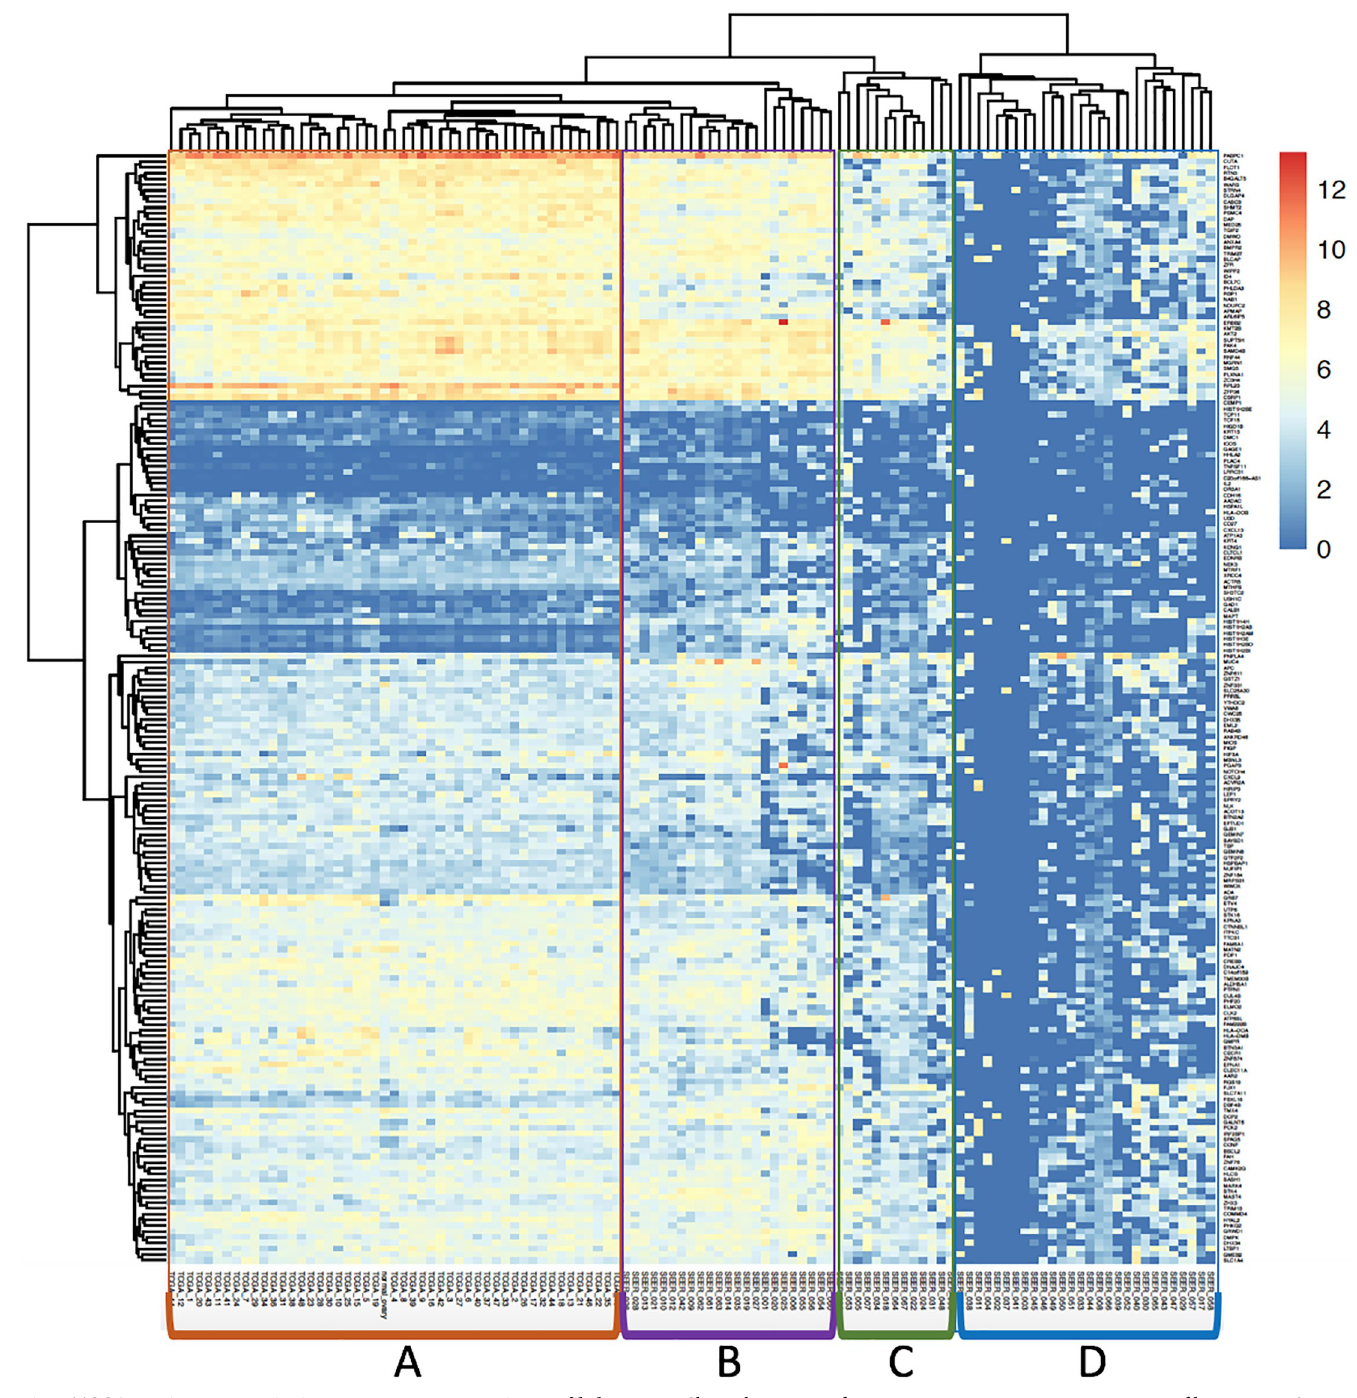
Fig 8. TCGA ovarian prognostic signature gene set expression profile heat map. Cluster heat maps of 193 ovarian prognostic signature gene profile among 67 SEER FFPE samples, 48 TCGA ovarian tumor samples and one Human BodyMap normal ovary tissue sample. Each row represents a gene and each column represents a sample. The color and intensity of the boxes represent changes of gene expression. Genes and samples have been hierarchically clustered based on their gene expression pattern. Group A samples contain the 48 TCGA ovarian tumor samples and one Human BodyMap ovary tissue sample. Group B samples are the 26 SEER samples which display a good correlation with TCGA ovarian tumor samples. Group C samples are the 13 SEER samples which have low to medium overall gene expression of the 193 ovarian prognostic signature gene set. Group D samples contain the rest of the 28 SEER samples with very low overall gene counts.